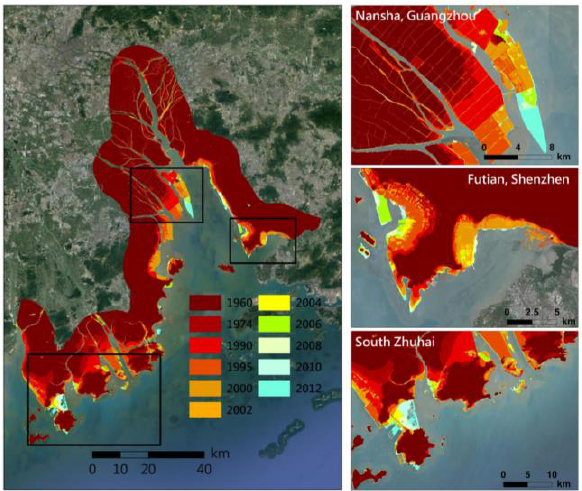
Figure 4. Land expansion map (1960~2012)